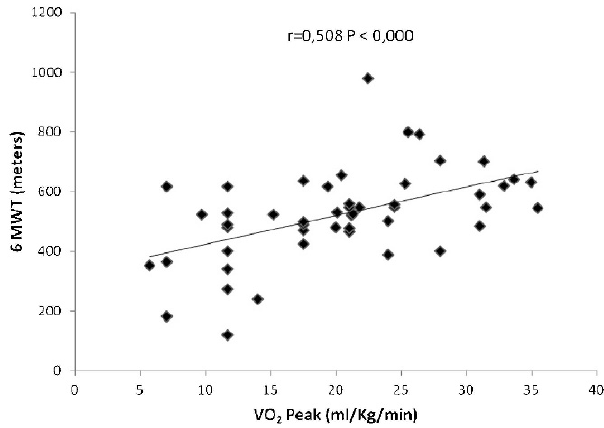
Figure 2 - Correlation between the six-minute walk test and peak